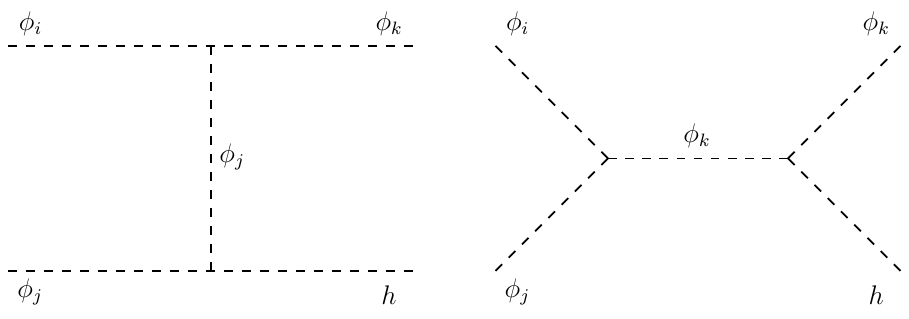
Figure 13 . DM semiannihilation channels involving three DM (cid:12)elds.